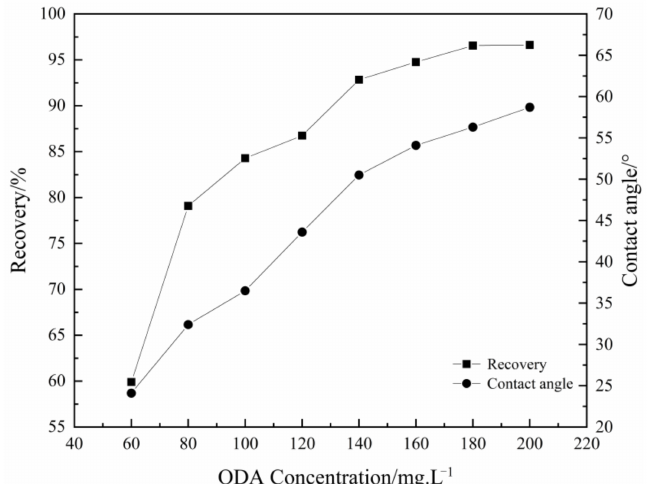
Figure 15. Flotation recovery and contact angle of muscovite in relation to ODA concentration (pH = 4).